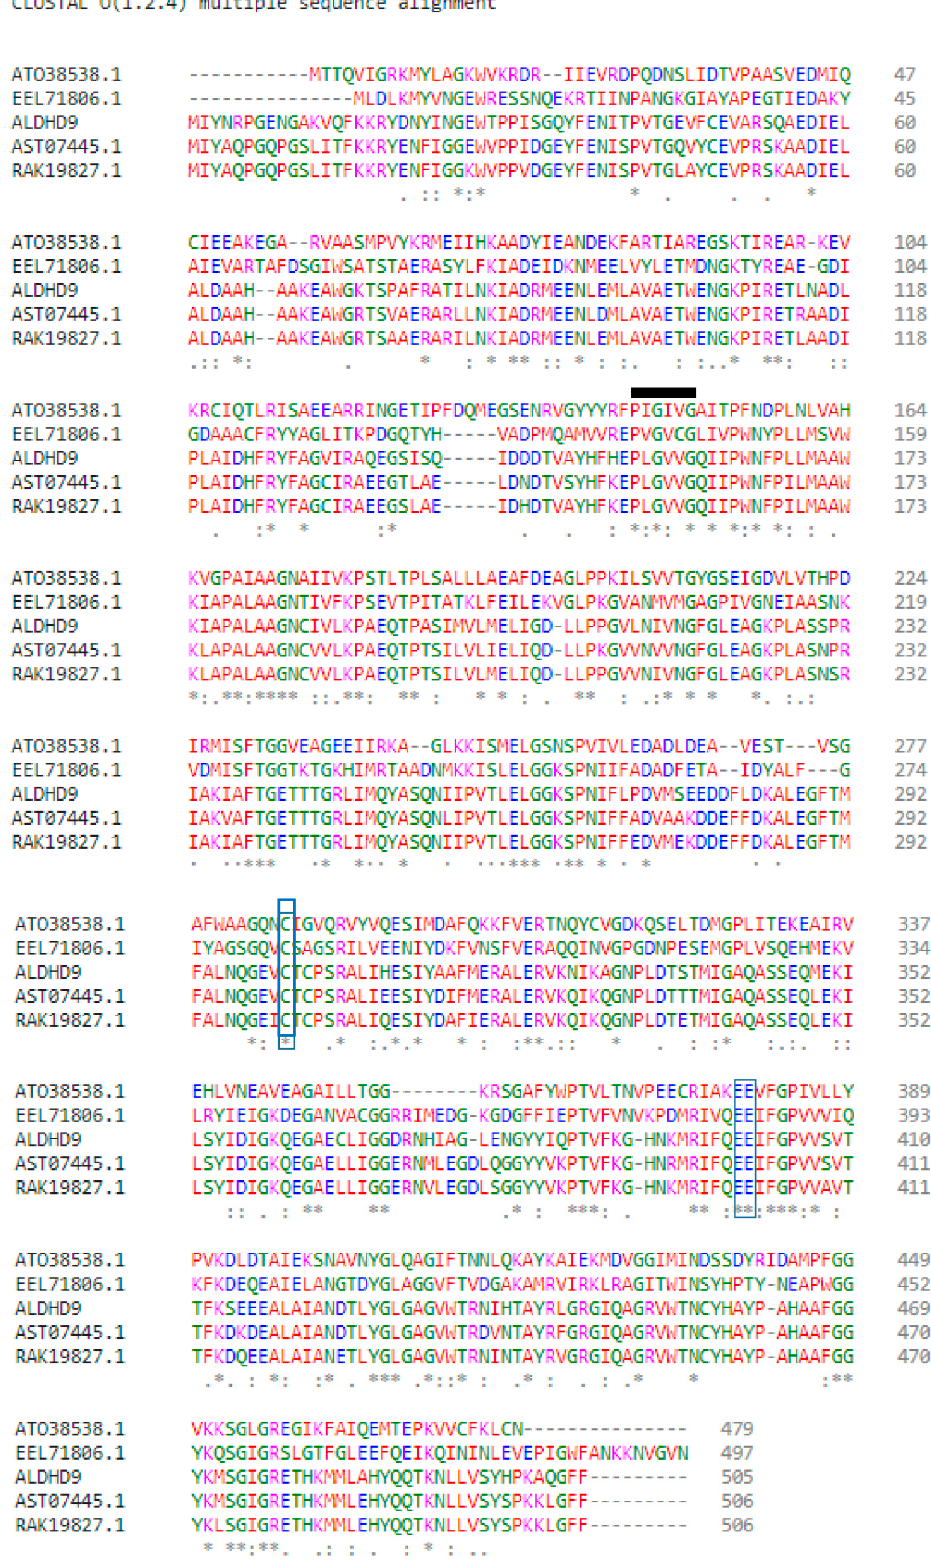
Figure 2. Multiple sequence alignment between the amino acid sequences of A. geothermalis ALDH from the Anoxybacillus geothermalis D9 (ALDH9) and Bacillaceae family. The * represents identical residue or strongly conserved region. The blue boxes show the catalytic residues, which are Cys301 and Glu399. The black line shows the motifs of A. geothermalis